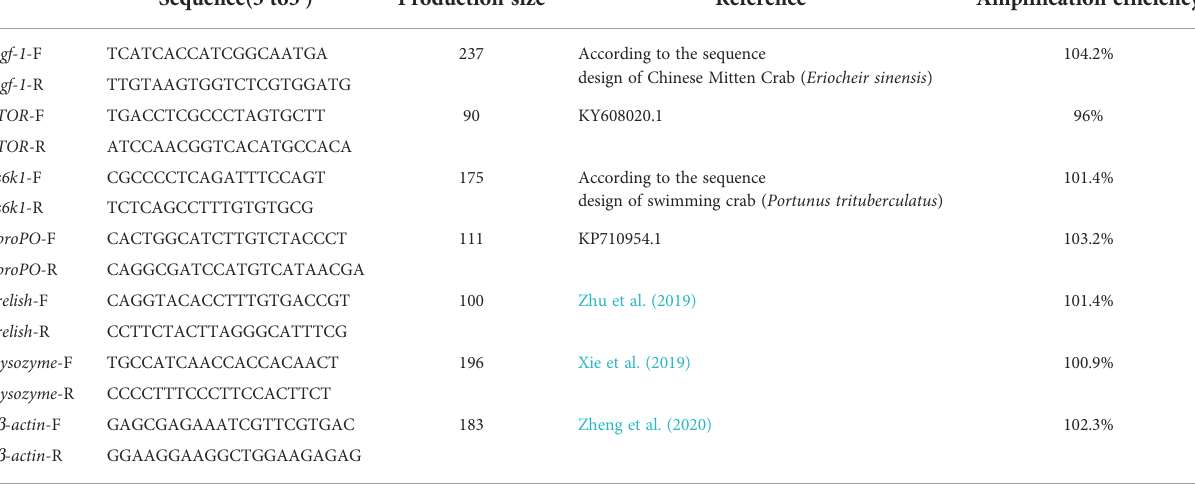
TABLE 4 The sequences of primers in this